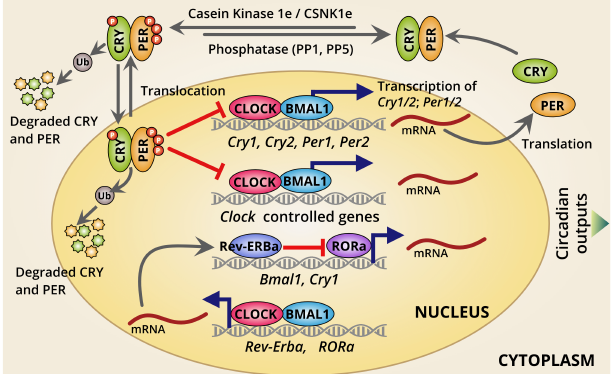
Figure 1. A typical circadian clockwork involved in mammalian cells. It consists of two clockworks, the primary and the secondary TTFLs. A set of core clock genes in those two TTFLs are essential for producing the 24-h self-sustained indigenous oscillations. The primary TTFL composed of CLOCK, BMAL1, CRY, and PER. The CLOCK:BMAL1 heterodimer induces the clock-controlled genes and CRY and PER act as negative regulators for their own transcriptions. In the secondary TTFL, the Rev-Erb α and ROR α are induced by the CLOCK:BMAL1. Their product ROR α counteracts with the primary clock